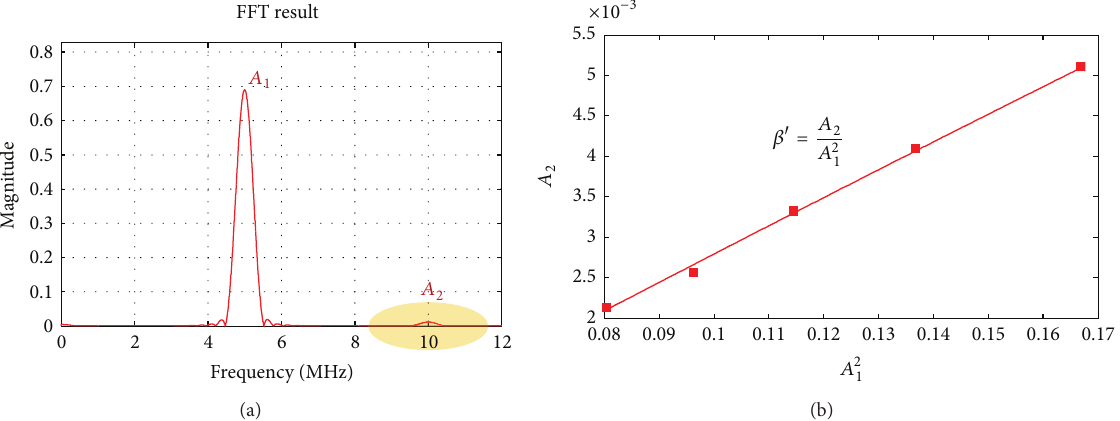
Figure 2: (a) Magnitude spectrum of the received signal and (b) experimental result to show the dependency of the second-harmonic amplitude on the power of fundamental frequency component.